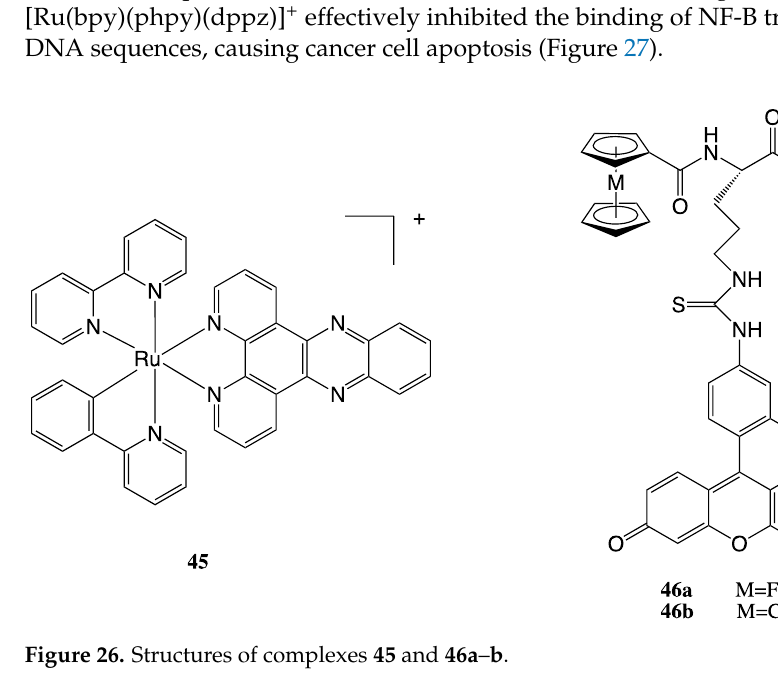
Figure 27. Representation of [Ru(bpy)(phpy)(dppz)] + nucleus-targeting activity. (Reprinted with permission from ref. [108]. Copyright 2014 American Chemical Society). Concerning extrinsic targeting, Noor et al. synthesised a bioconjugate where an or- ganometallic complex, a cobaltocenium cation, was linked to an NLS peptide, SV-40 T (with primary sequence H-Pro-Lys-Lys-Lys-Arg-Lys-Val-OH) [109]. The conjugate shows enhanced cellular uptake and a significant accumulation in the nucleus of HepG2 cells. The same group studied the uptake and cellular localization of some neutral ferrocene (Fe 2+ ) and positively charged Cobaltocenium (Co 3+ ) bioconjugates ( 46 , Figure 26) [110], where the metal-based core was conjugated with the NLS wild-type sequence PKKKRKV. Although they did not find the complexes cytotoxic on the Hep G2 cell line, for both metal centres the fluorescence microscopy study showed significant cellular uptake and nuclear localization of the conjugates. Interestingly, the results obtained are similar for the two metal centres, thus highlighting that the positive charge may not appear decisive in nu- clear targeting.